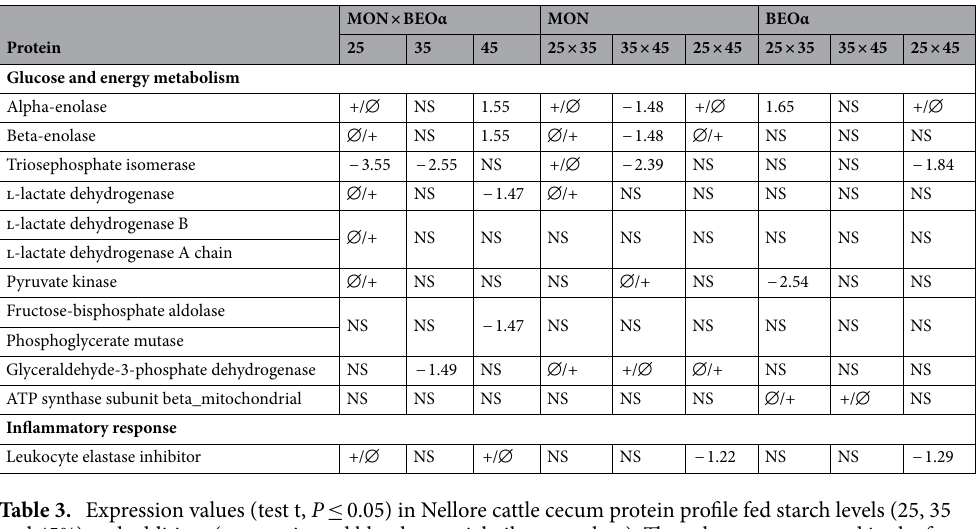
Table 3. Expression values (test t, P ≤ 0.05) in Nellore cattle cecum protein profile fed starch levels (25, 35 and 45%) and additives (monensin and blend essential oil + α-amylase). The values are presented in the form log2FC (Fold Change) calculated in relation to the type of additives used, and subsequently the level of starch with the respective additives. NS not significant, +/ ∅ spot present in the first group in relation to the second, ∅ /+ spot absent in the first group in relation to the second.